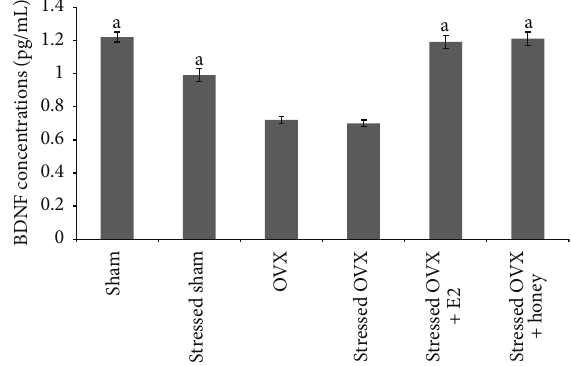
Figure 2: Effects of Tualang honey and E2 treatments on BDNF concentrations. Each column represents the mean ± SEM of 10 rats; a 𝑃 < 0.05 compared with the stressed OVX group.